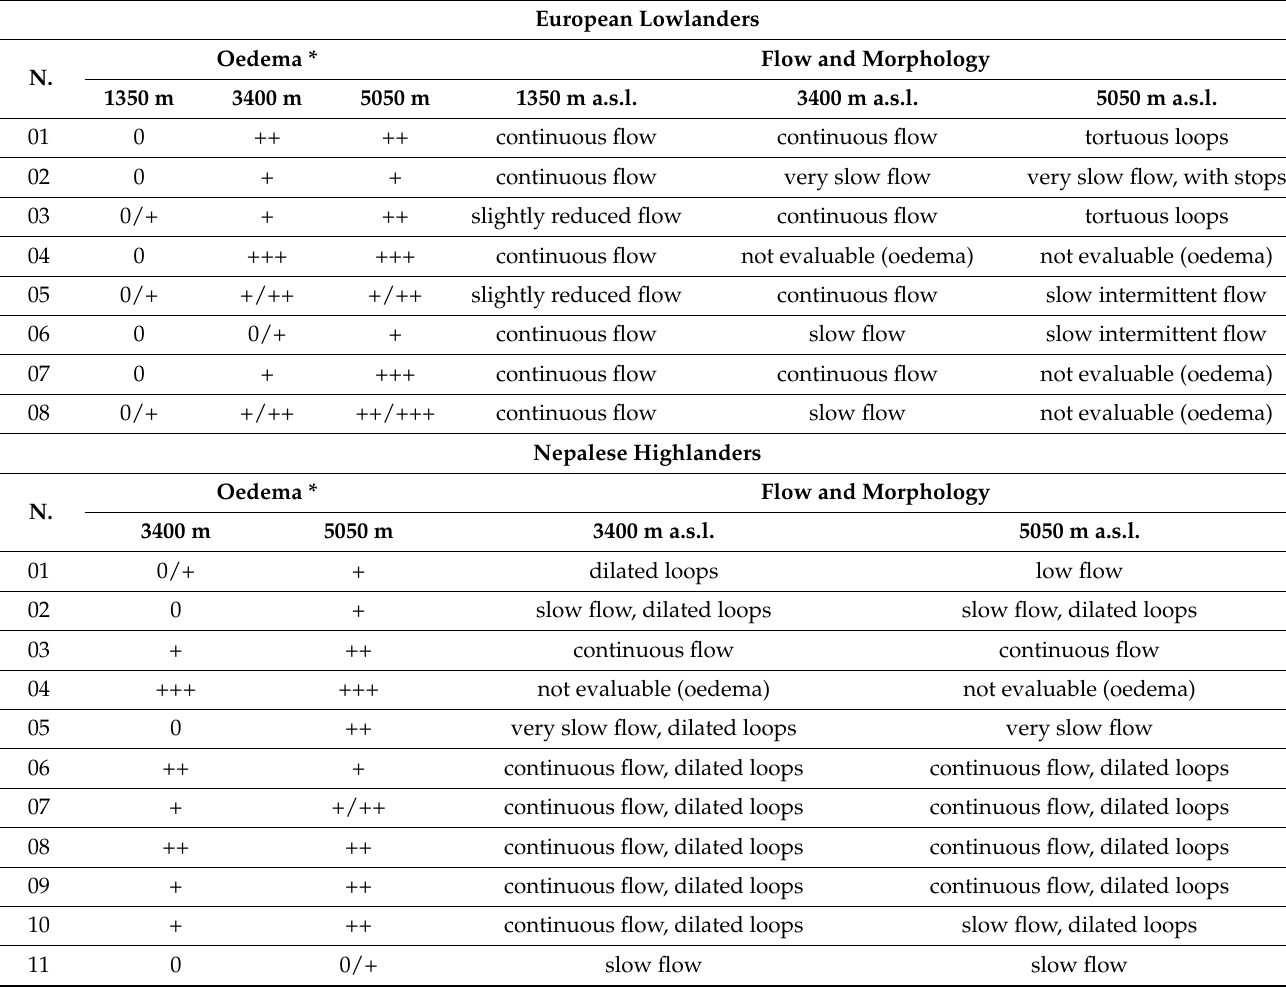
Table 4. Microvascular change with altitude. Periungual